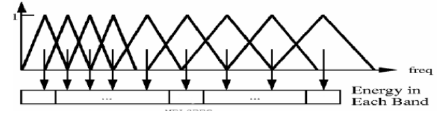
Figure 4: Triangular filters of